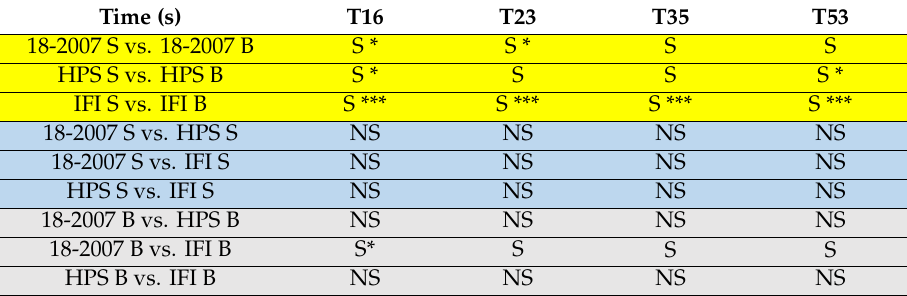
Table 3. ANOVA of the di ff erent wines’ foaming properties between 16 and 53 s. S, Significant statistical di ff erences for P < 0.05. S *, Significant statistical di ff erences for P < 0.025. S **, Significant statistical di ff erences for P < 0.01. S ***, Significant statistical di ff erences for P < 0.001. NS, Non-Significant statistical di ff erences ( P > 0.05). Comparisons between sound S (healthy) and botrytized B wines (yellow), between sound wines (blue) and between botrytized wines